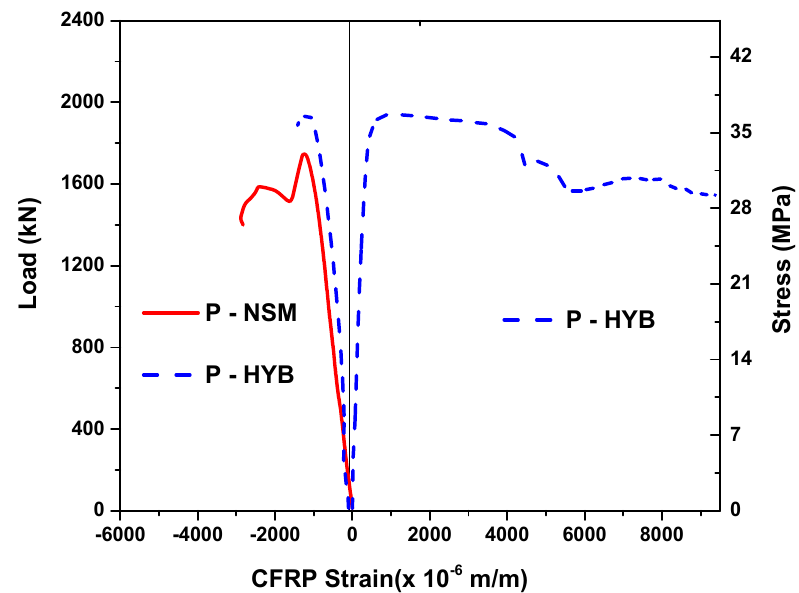
Figure 5. Overall load-displacement behaviour of pre-damaged PC columns.